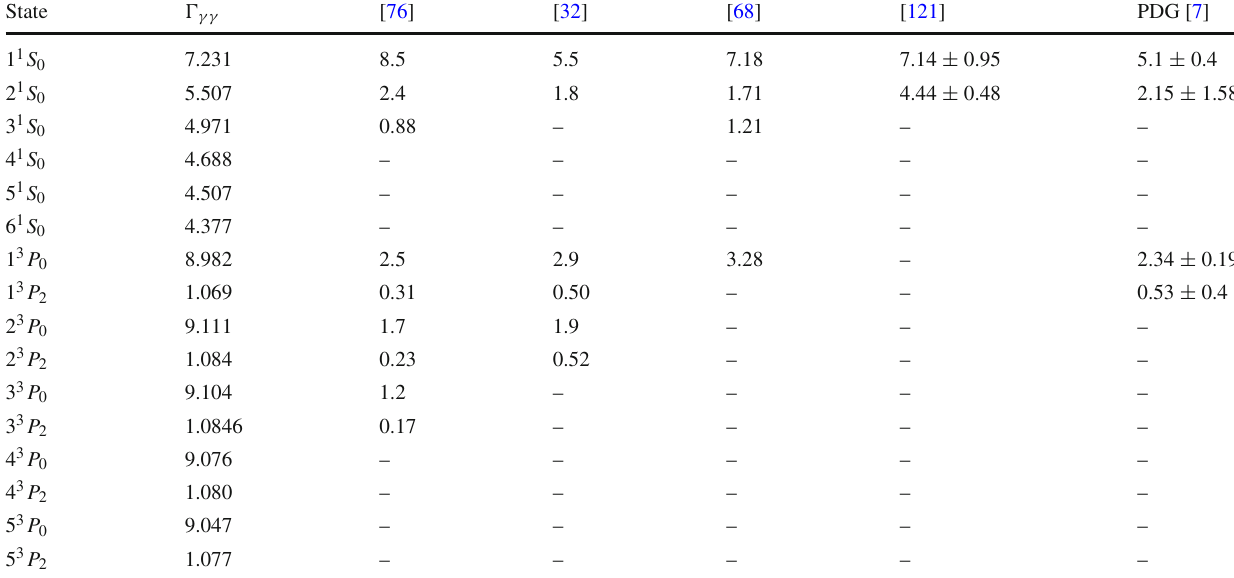
Table 14 Digamma decay width of S and P -wave charmonia (in keV)